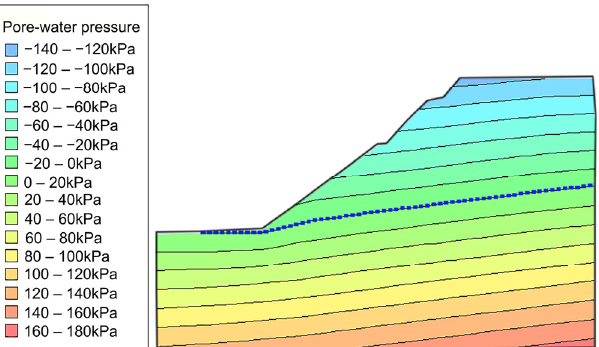
Figure 5. Pore water pressure distribution in a natural state, where the blue dashed line is the phreatic line.